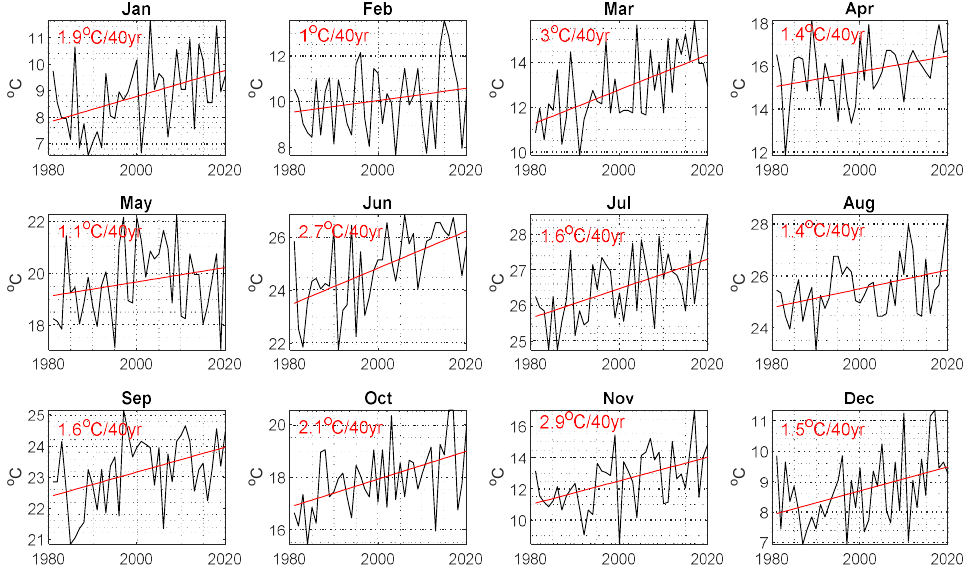
Figure 3. Average 1981–2020 monthly temperature from the Santa Cruz River near the border crossing from Sonora to Arizona. Data are available from the 4 km monthly climatological gridded surface meteorological dataset [11]. The estimated linear trend are shown as red lines and the estimated monthly rate of change over 40 years are indicated at the top left of the